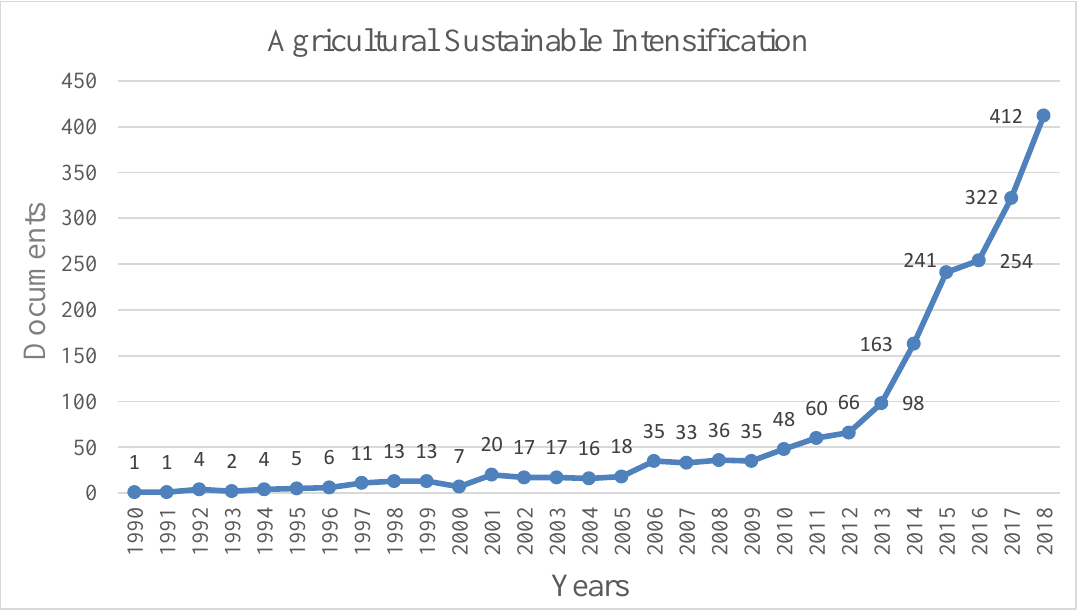
Figure 2. Literature number of agricultural sustainable intensification issued in 1990–2018. Data Source: Web of Science Core Collection.